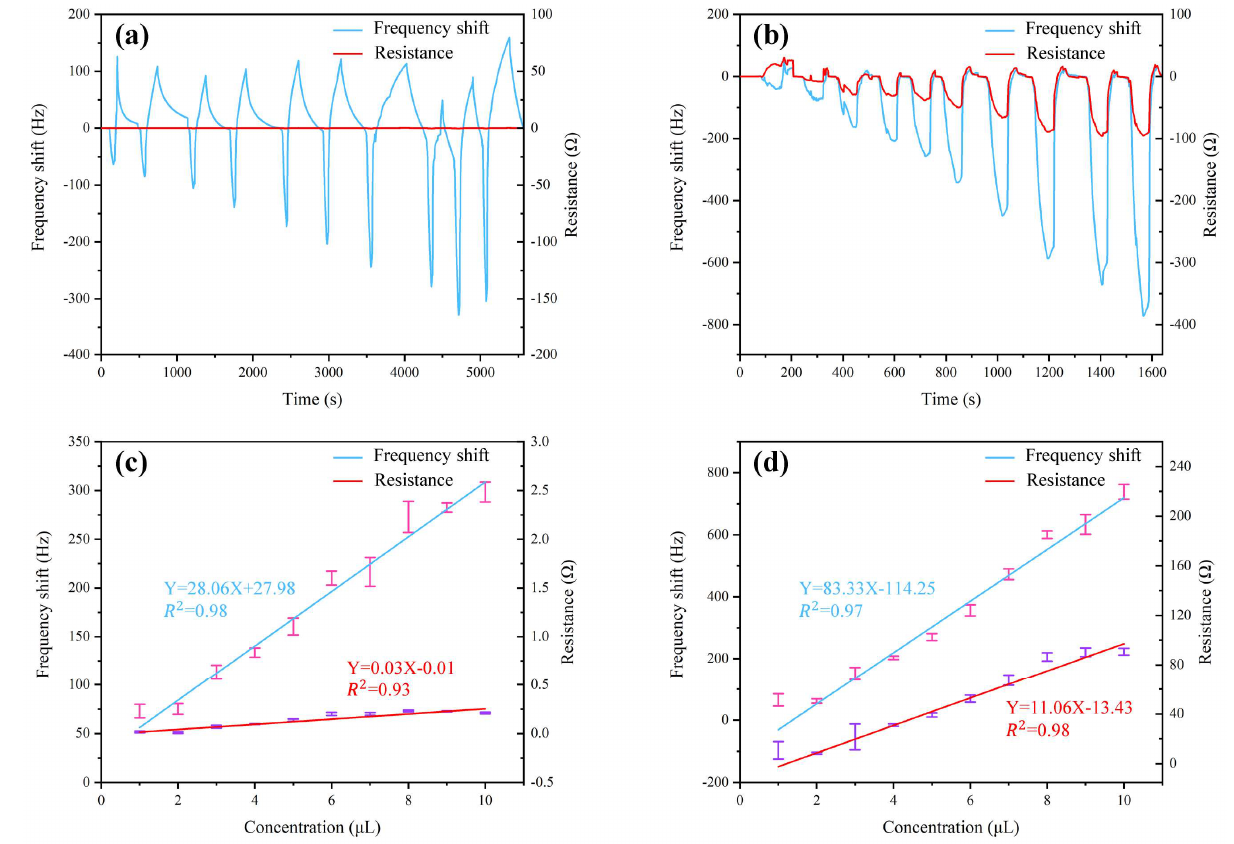
Figure 5. Sensing performances of QCM sensors for TMA detection. ( a ) Frequency and resistance response curves of the GO-based QCM sensor, ( b ) frequency and resistance response curves of the NGO-based QCM sensor, ( c ) response amplitude regression curves of the GO-based QCM sensor, and ( d ) response amplitude regression curves of the NGO-based QCM sensor.